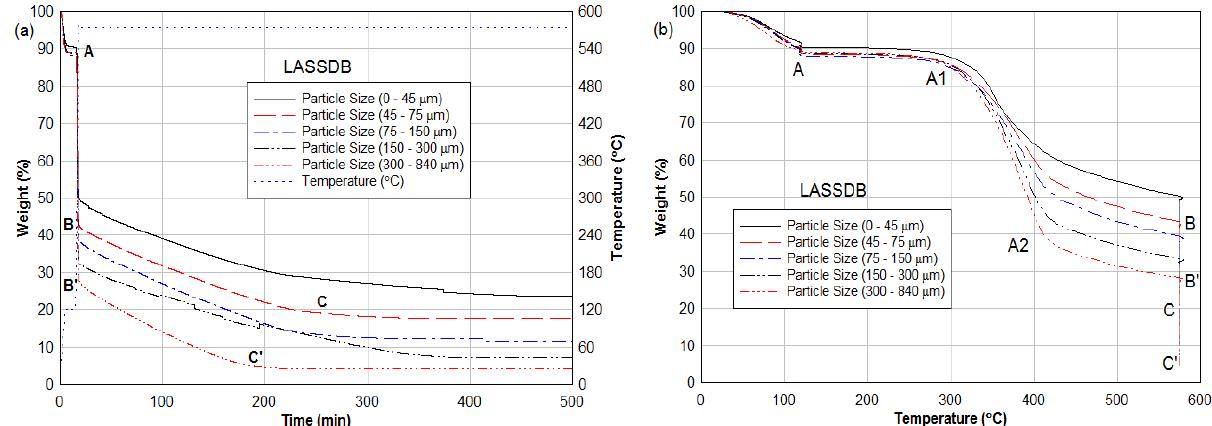
Figure 6. Pyrolysis results using TGA for different particle sizes of LASSDB: ( a ) weight % vs. time with particle size as the parameter and ( b ) weight % vs. temperature with particle size as the parameter.